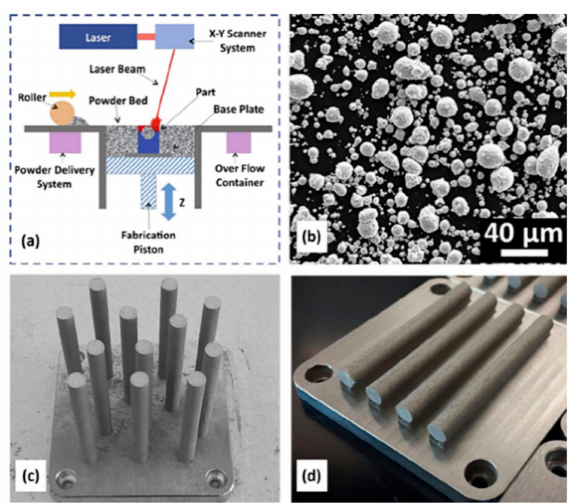
Figure 1. ( a ) Schematic of laser powder bed fusion (L-PBF) process, ( b ) gas-atomized (argon) 17–4 precipitation-hardened (PH) stainless steel (SS) powder; ( c ) vertically and ( d ) horizontally orientated cylindrical bars of 17–4 PH SS samples